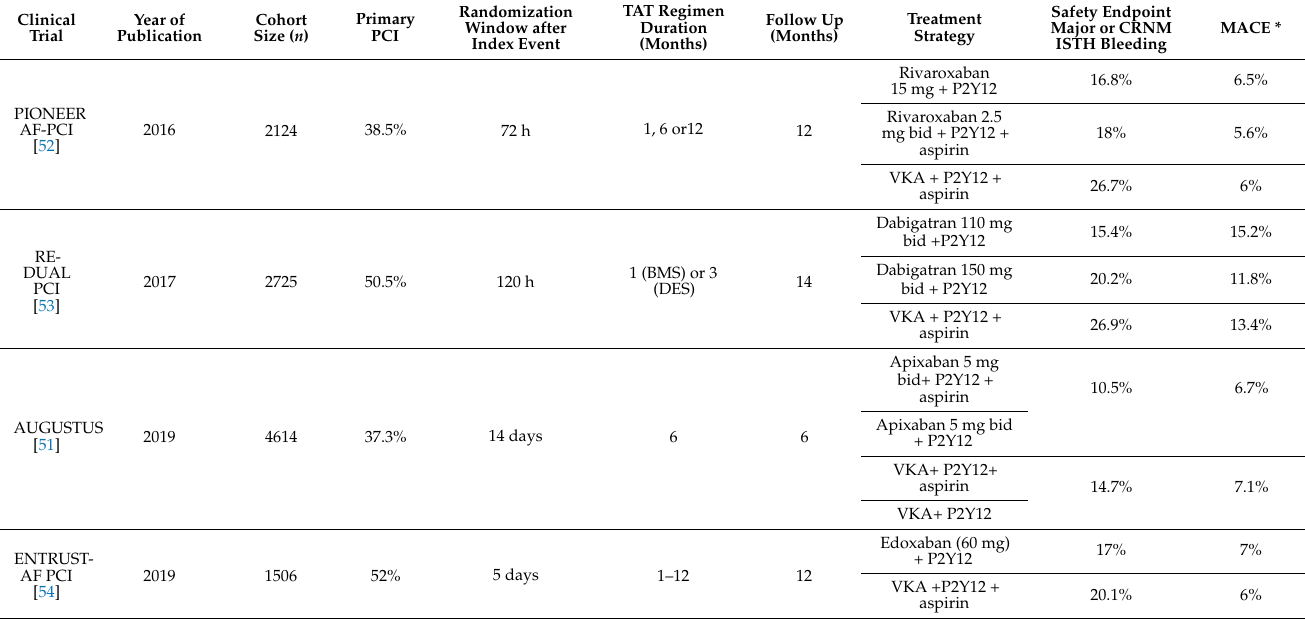
Table 1. Main characteristics and results of the PIONER AF-PCI, RE-DUAL PCI, AUGUSTUS and ENTRUST-AF PCI trials